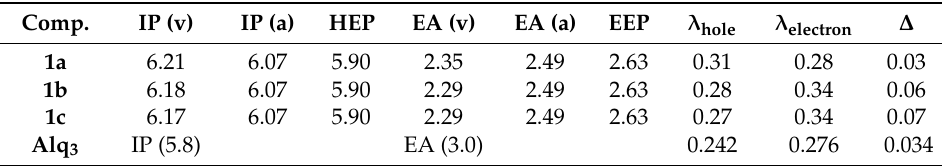
Table 2. Ionization potentials, electron affinities, extraction potentials, internal reorganization energies, and ∆ = | λ h − λ e | (in eV) for the studied complexes.